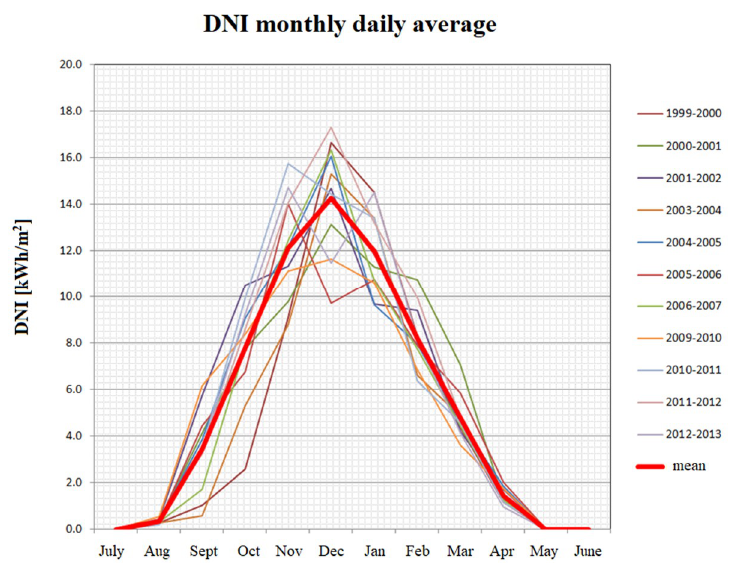
Figure 11. Annual evolution of the daily average monthly DNI values and mean annual evolution (in red) at Eneide (MZS) station.